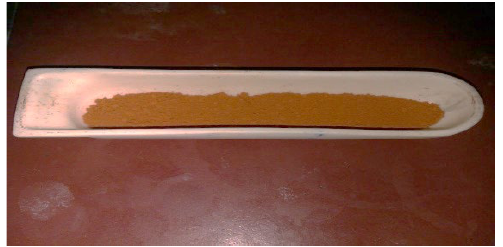
Figure 1. Maghemite nanostructure Preparation of PVA beads